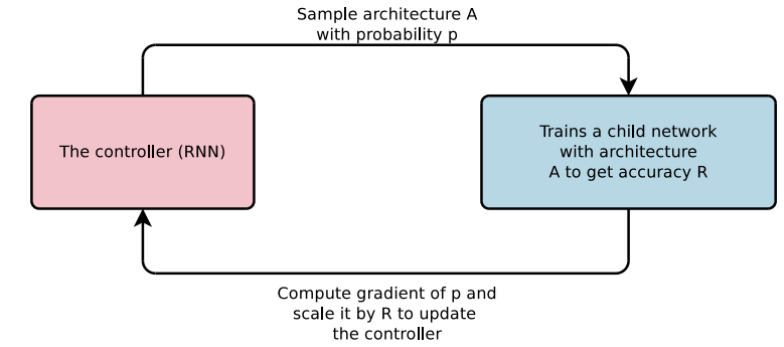
Figure 6. An overview of NAS with RL. (Reprinted from ref. [11]).